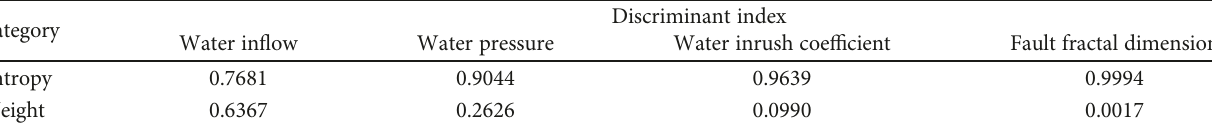
Figure 4: The contour map of water inrush coe ffi cient. Table 3: Calculation results of entropy and weight